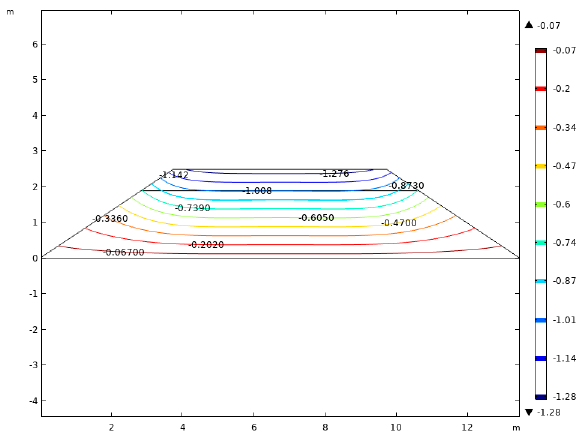
Figure 20. Contours of vertical displacement at the steady state (time is 11,000 min) of fluid flow (unit: mm).